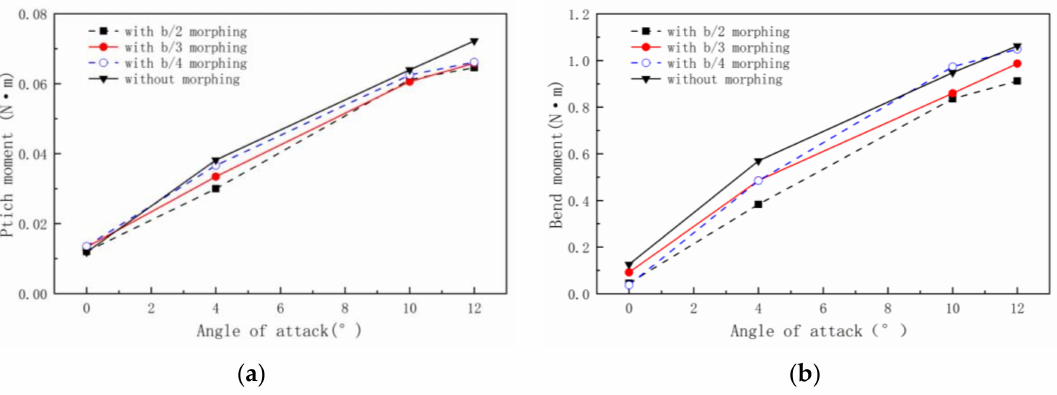
Figure 13. ( a ) Pitch moment and ( b ) bend moment of different wing models at different